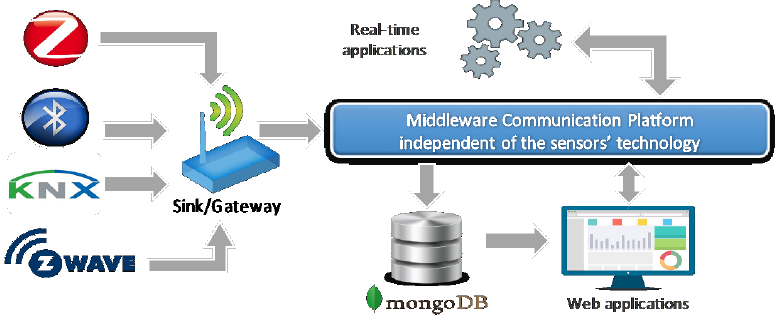
Figure 1. How heterogeneous systems communicate.